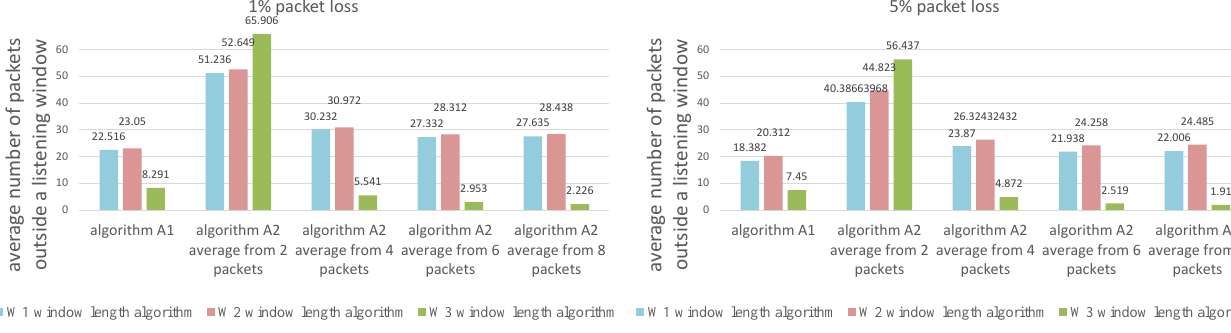
average from 2 packets